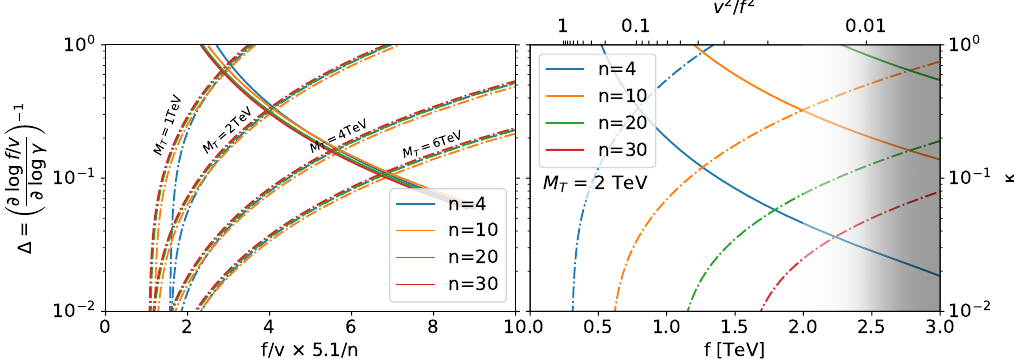
Figure 4 . Sources of fine tuning in the Gegenbauer Higgs model for N = 4 . Solid lines provide the log-derivative tuning of f/v that is independent of M T (left axis), while dashed lines correspond to the Higgs mass tuning arising from the top sector and controlled by κ (right axis). In the right √ panel, the shaded region for which f & 2 M T /y t is inaccessible in coloured top partner models reproducing the observed top-quark